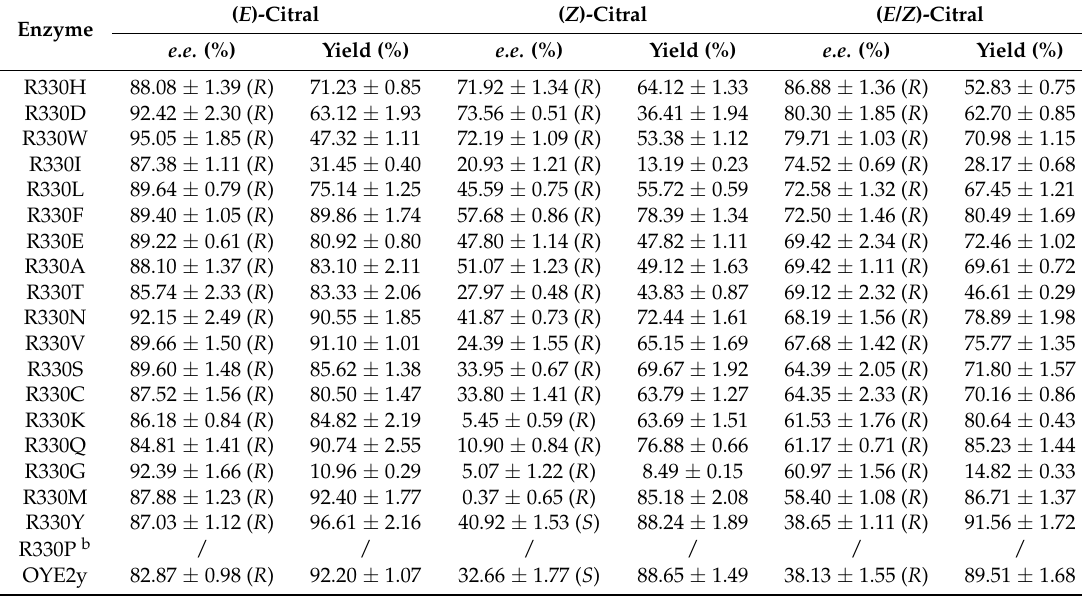
Table 2. The catalytic performance of OYE2y and its R330X variants a